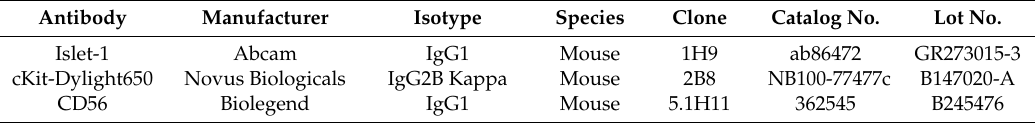
Table 1. Antibodies Used for Flow Cytometry.